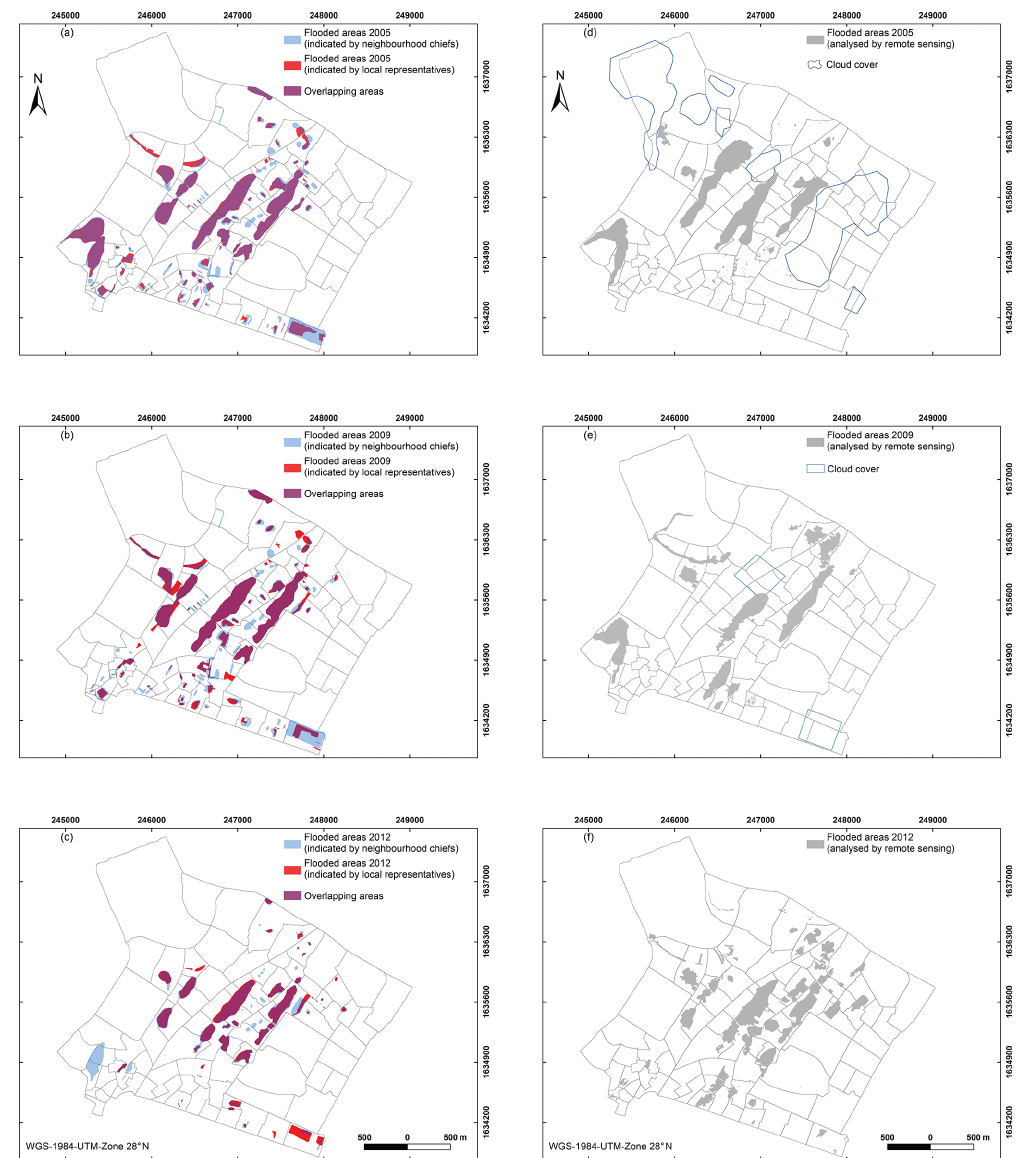
Figure 4. Spatial distribution of flooded areas based on citizen science techniques in (a) 2005, (b) 2009 and (c) 2012. Flooded areas based on remote sensing data in (d) 2005, (e) 2009 and (f)